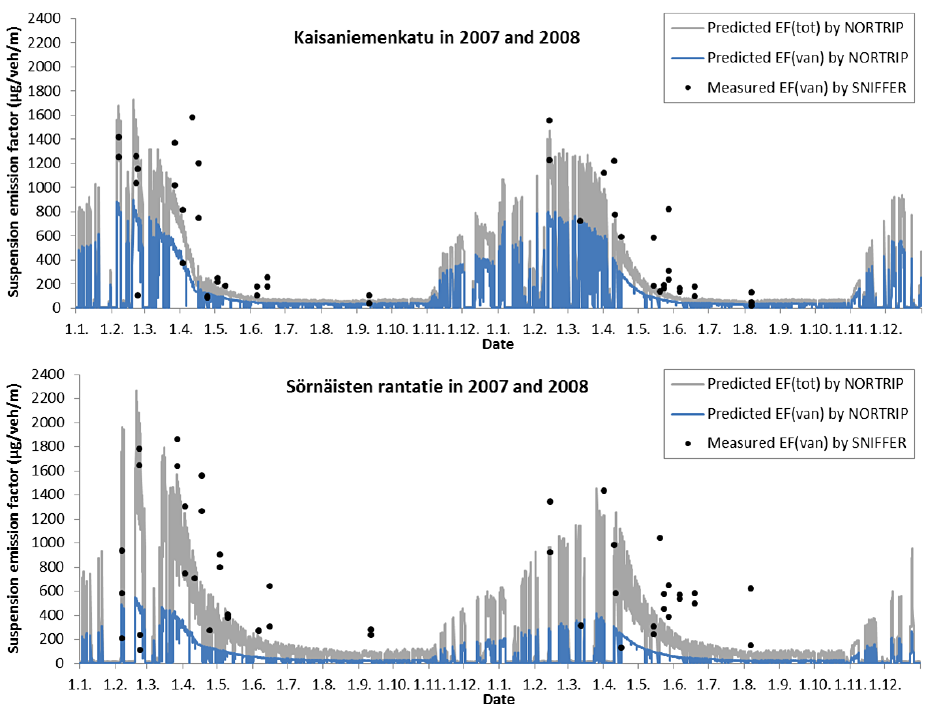
Figure 5. Hourly average suspension emission factors for all traffic (EF tot ) and for a van (EF van ) , predicted using the NORTRIP model and measured in Kaisaniemenkatu (upper panel) and Sörnäisten rantatie (lower panel) in 2007 and